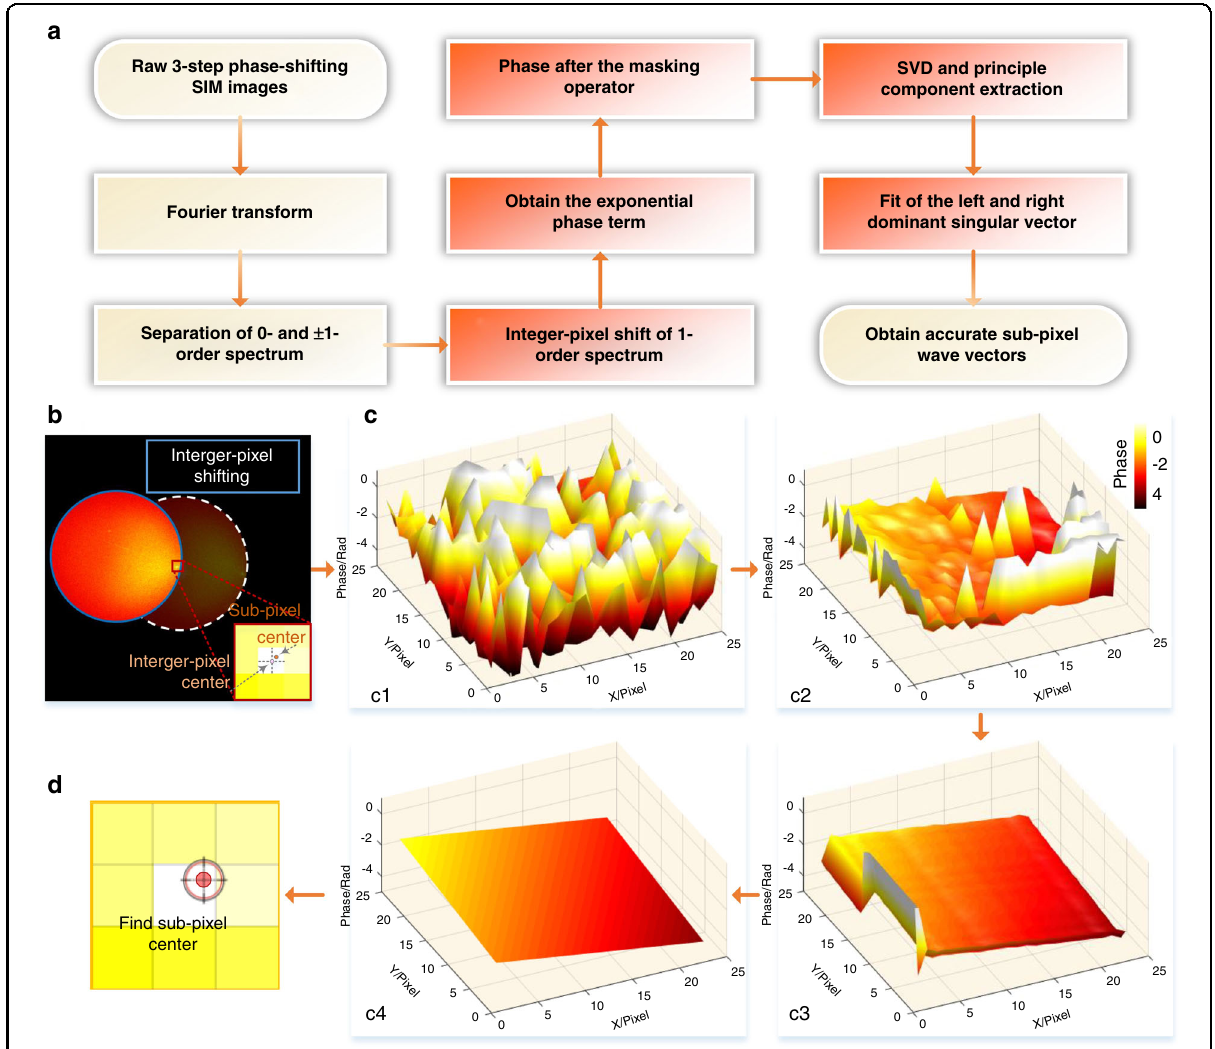
Fig. 1 Schematic diagram of PCA-SIM. a Flow chart of the parameter estimation in PCA-SIM. b – d Output results of red boxes in a . b The 1 st -order spectrum after being shifted interger-pixel frequency vector. c The phases of the phasor matrix obtained from b after different operations: the original phases ( c1 ), phases after applying the masking operator ( c2 ), phases after applying PCA ( c3 ), and phases after least-squares fi tting ( c4 ). d Obtained frequency vector with sub-pixel